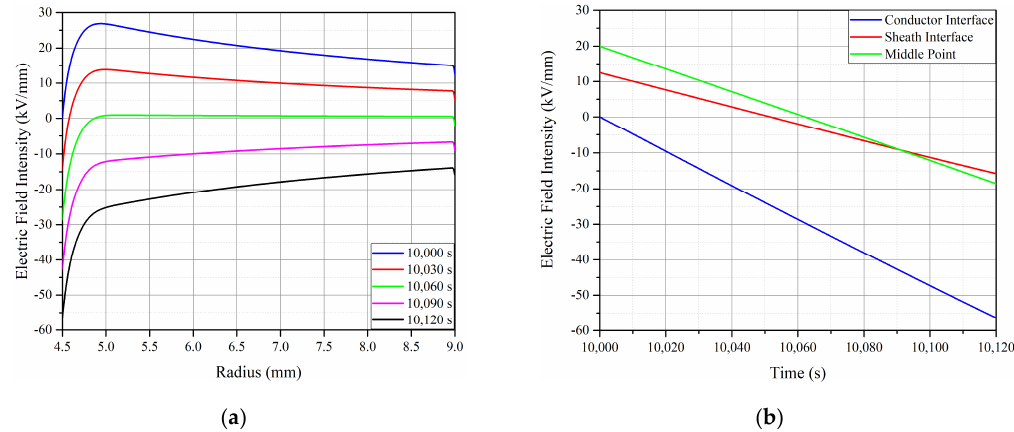
Figure 7. Space charge distribution at 250 A: ( a ) Conductor side charge density (C/m 3 ); ( b ) sheath side charge density (C/m 3 ).